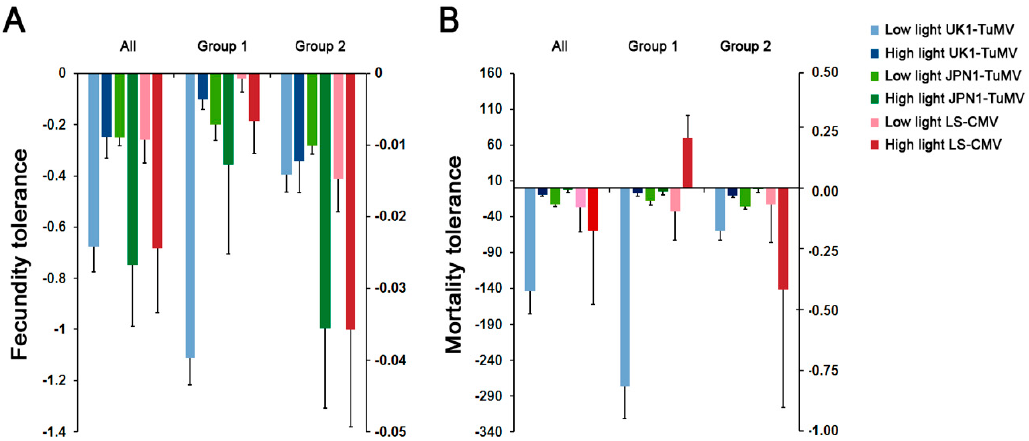
Figure 3. Arabidopsis fecundity and mortality tolerance to UK1-TuMV, JPN1-TuMV and LS-CMV. ( A ) Values of fecundity tolerance to virus infection measured as the slope of the SW to virus accumulation linear regression. ( B ) Values of mortality tolerance to virus infection measured as the slope of the LP to virus accumulation linear regression. Values are mean ± standard error of 18 (All), 7 (Group 1) and 11 (Group 2) Arabidopsis accessions.